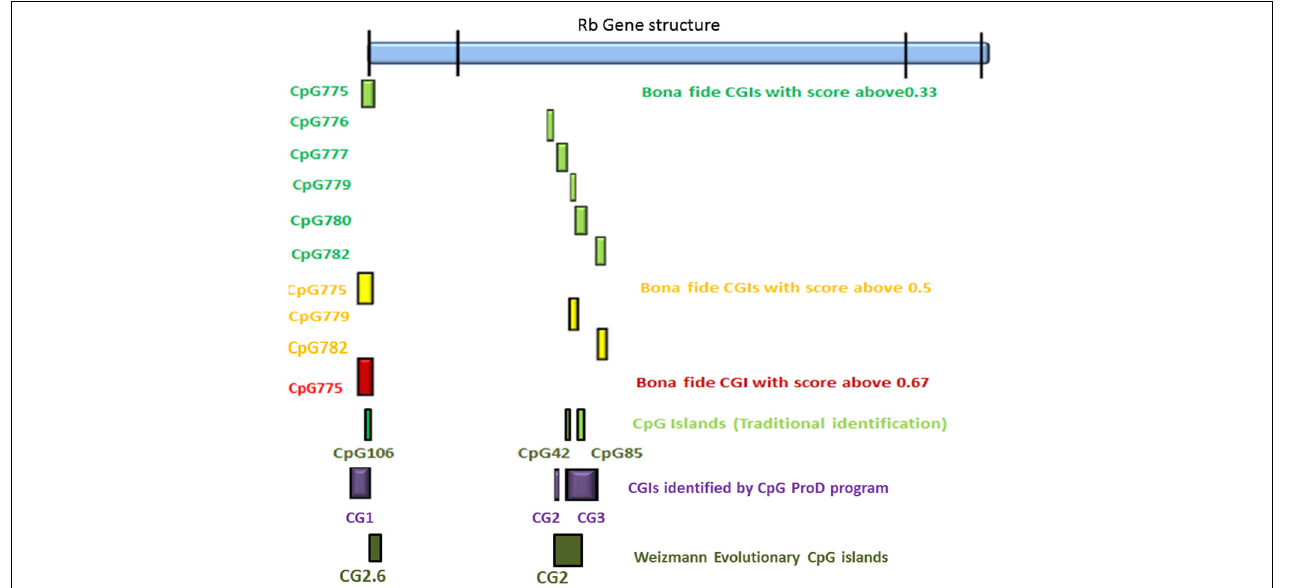
FIGURE 2 | The positions of CpG islands in the Rb1 locus. The first and last blocks in the schematic gene represent the first and fourth exons of Rb1 , respectively. “Bona fide” strategy accounts for a number of functional CGIs and estimates their strengths (see